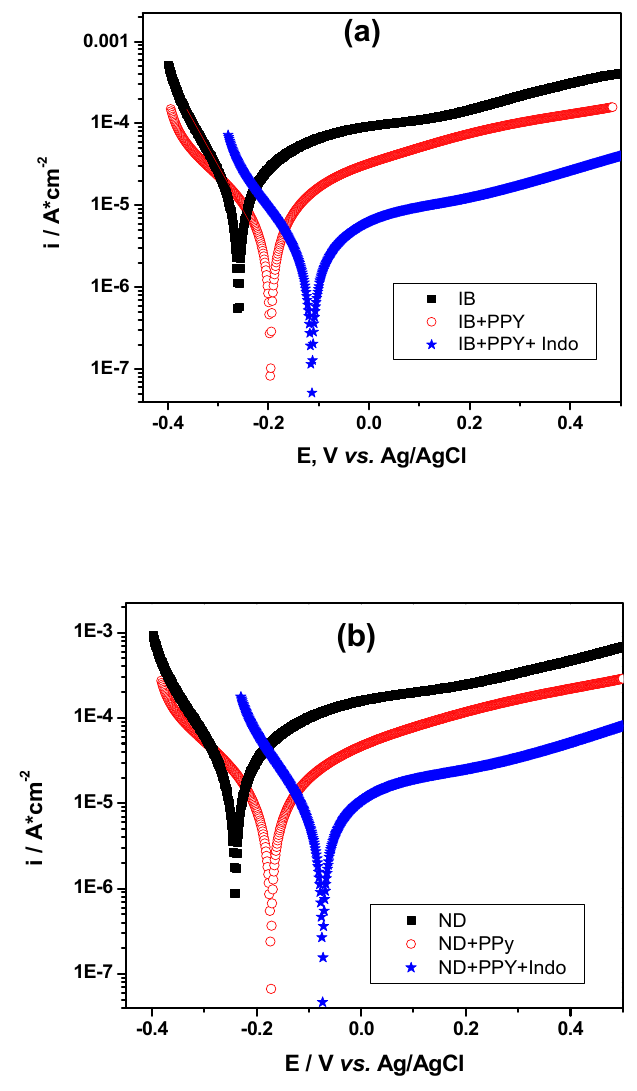
Figure 9. Polarization curves in semilogarithmic coordinates for PPy and PPy-Indo films formed at constant applied potential of 1.1 V / Ag on: ( a ) IB and ( b ) ND alloy substrates from ILM-ACN electrolyte containing 0.5 M Py and 0.0175 M Indo. Curves were recorded in SBF at 25 °C, scan rate 5 mV s − 1.